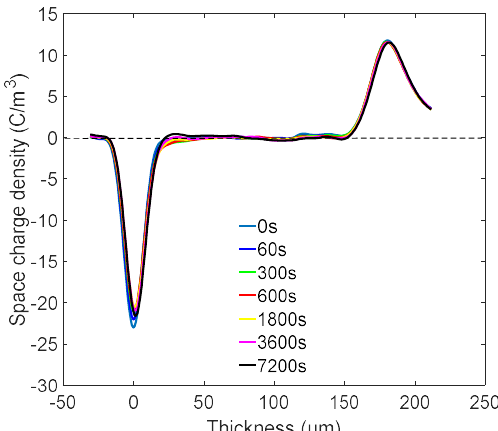
Figure 5. PEA measurement results in the degassed XLPE samples at 20 kV/mm field under room temperature.